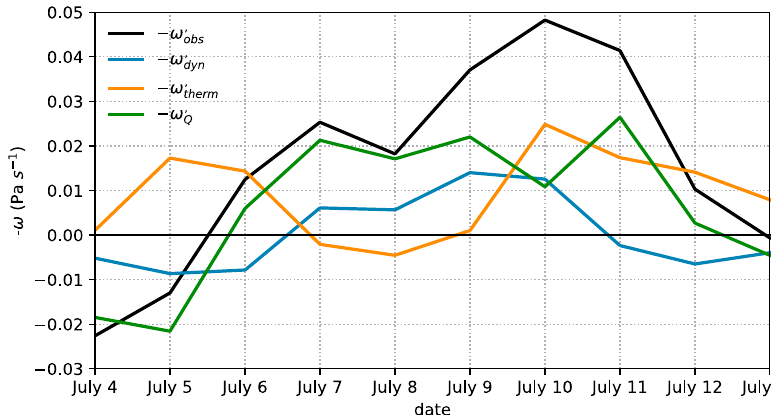
Figure 7. Time series of the observed 500 hPa omega anomalies ( ω (cid:48) obs , black line), the 500 hPa omega anomalies induced by the di ff erential vorticity advection ( ω (cid:48) dyn , blue line), the temperature advection ( ω (cid:48) therm , orange line), and the diabatic heating ( ω (cid:48) Q , green line) averaged over the region surrounding the Sichuan Basin (green rectangle in Figure 5) during the period 4–13 July 2018. Note that − 1 was multiplied to omega anomalies for visual